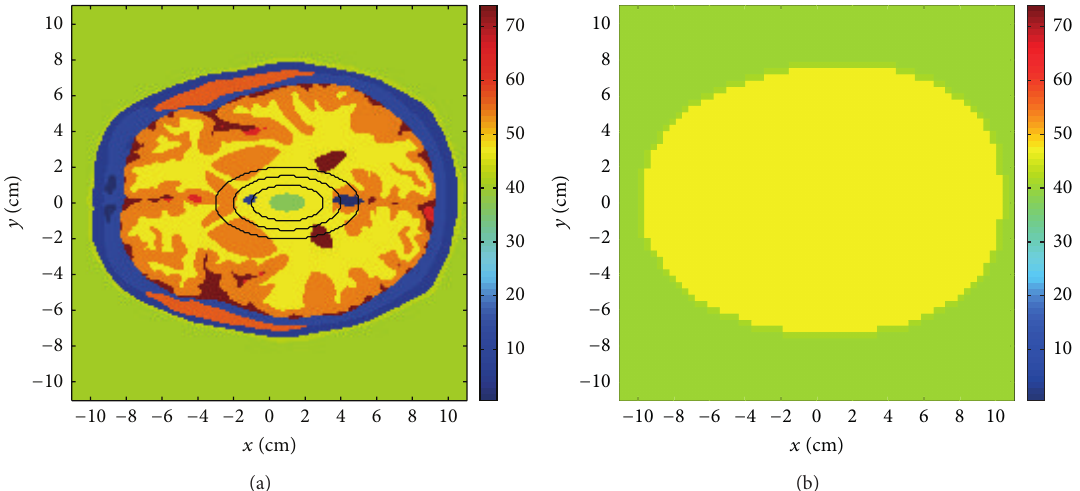
Figure 2: The 2D phantom: (a) scenario at the time 𝑡 0 : the stroke area is represented by the green ellipse at the center of the head, while the black contours represent its growth during the monitoring time, that is, the stroke’s size at time instants 𝑡 1 , 𝑡 2 , and 𝑡 3 , respectively; (b) Nonspecific reference scenario used for the TSVD inversion scheme.